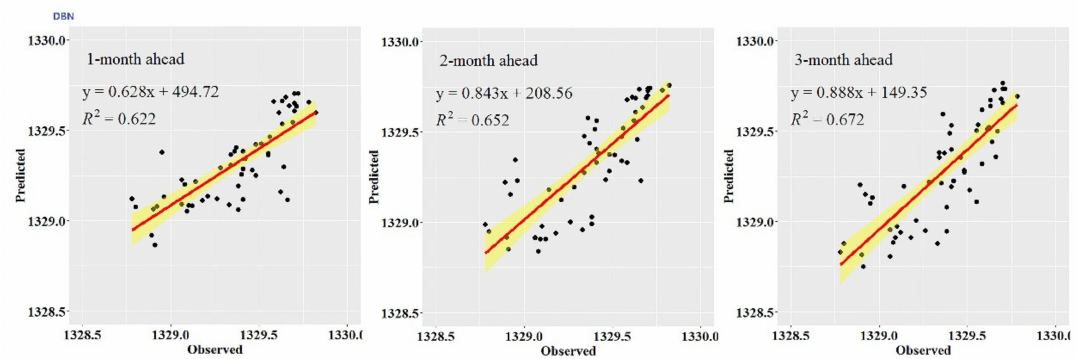
Figure 8. Observed vs. predicted groundwater level of Well III generated by the CEEMDAN-GA-DBN, CEEMDAN-DBN and DBN models for 1-, 2- and 3-month ahead forecast in the testing period.